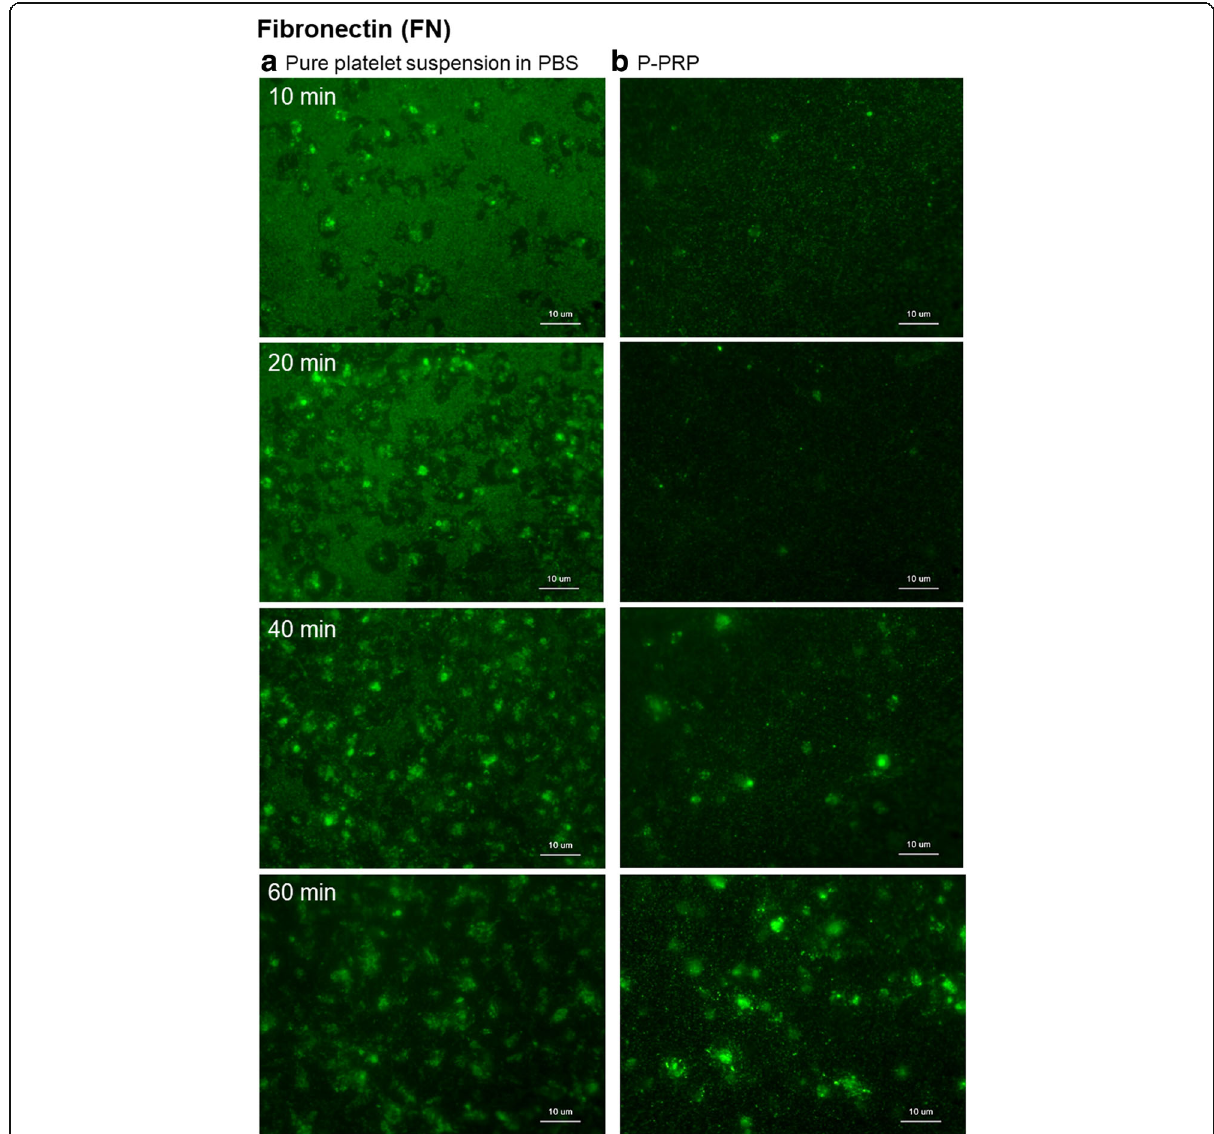
Fig. 6 Distribution of FN (green dye) on the surface of cp -Ti plates. a Platelets suspended in PBS and b P-PRP. FN fibronectin, cp - Ti commercially pure titanium, PBS phosphate-buffered saline, P - PRP pure platelet-rich